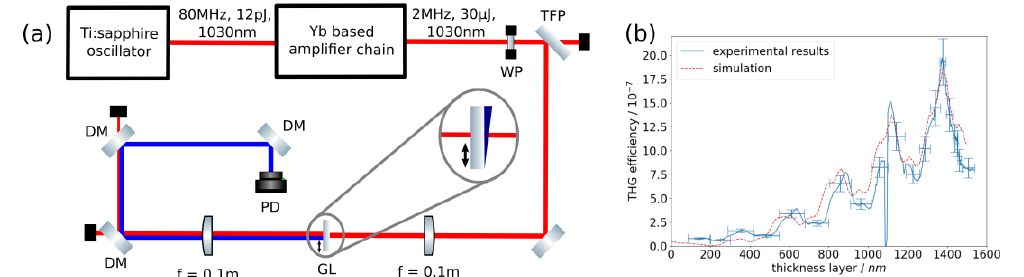
Fig. 1 (a) Experimental setup. WP: waveplate, TFP: thin film polarizer, GL: gradient layer, DM: dichroic mirror, PD: photodiode. (b) Experimentally measured (blue, solid) and simulated (red, dashed) THG efficiencies obtained for different layer thickness under consideration of linear and nonlinear effects in both, the layers material and the